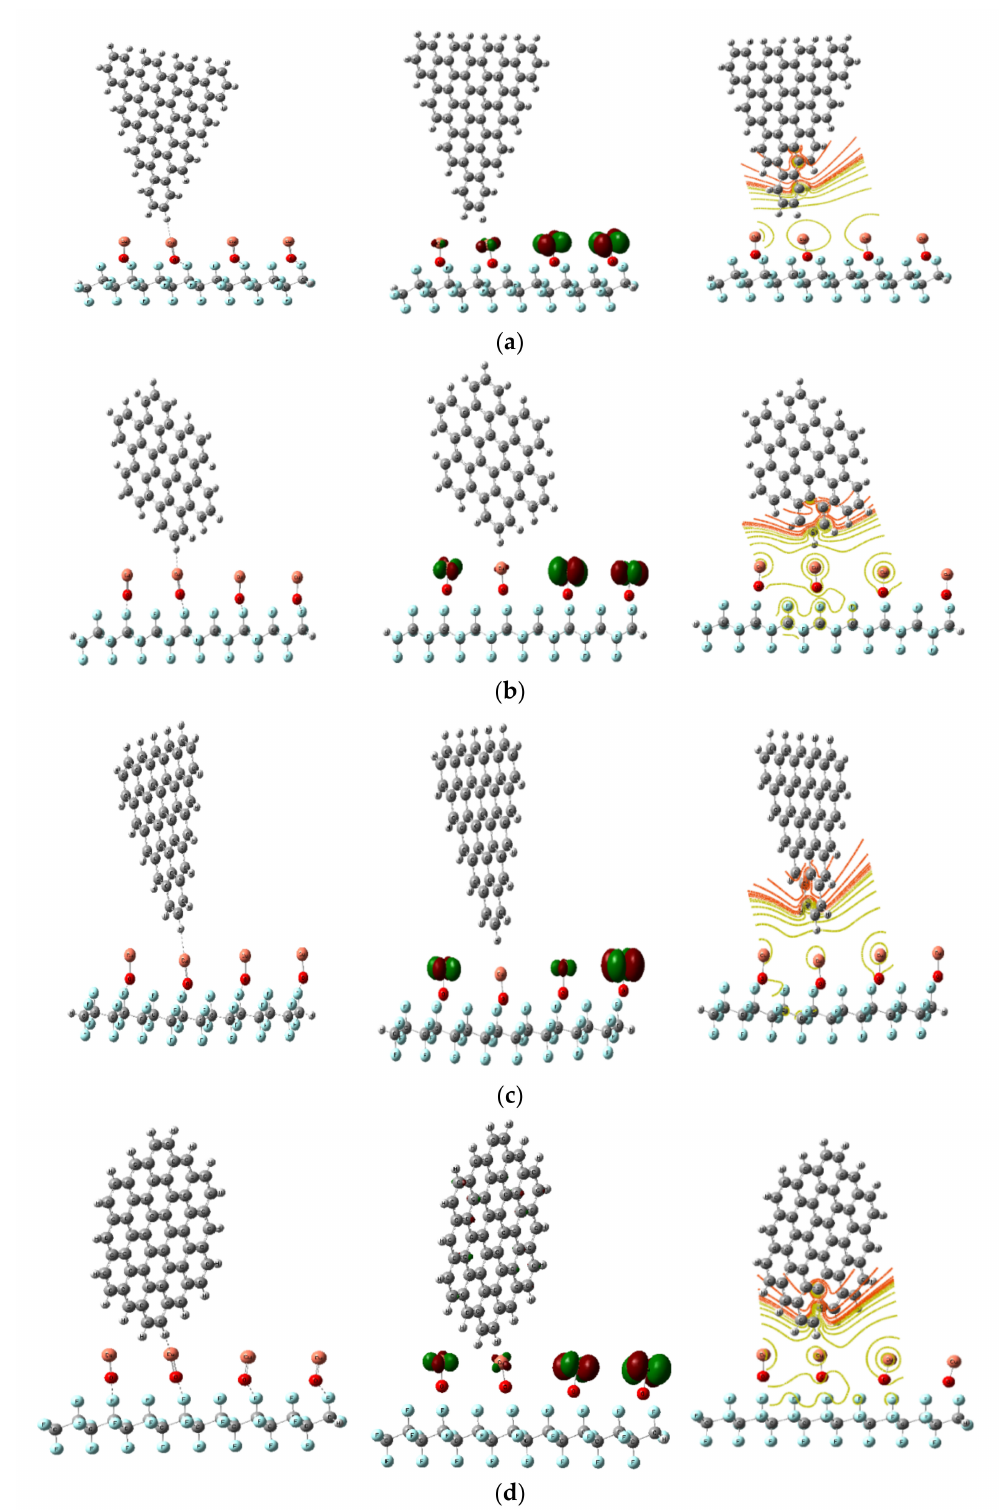
Figure 7. Model structure and calculated HOMO/LUMO orbital distribution and MESP mapping of PTFE/OCu reinforced with GQDs DFT:B3LYP/LANL2DZ as ( a ) PTFE/OCu/GQD ATRI